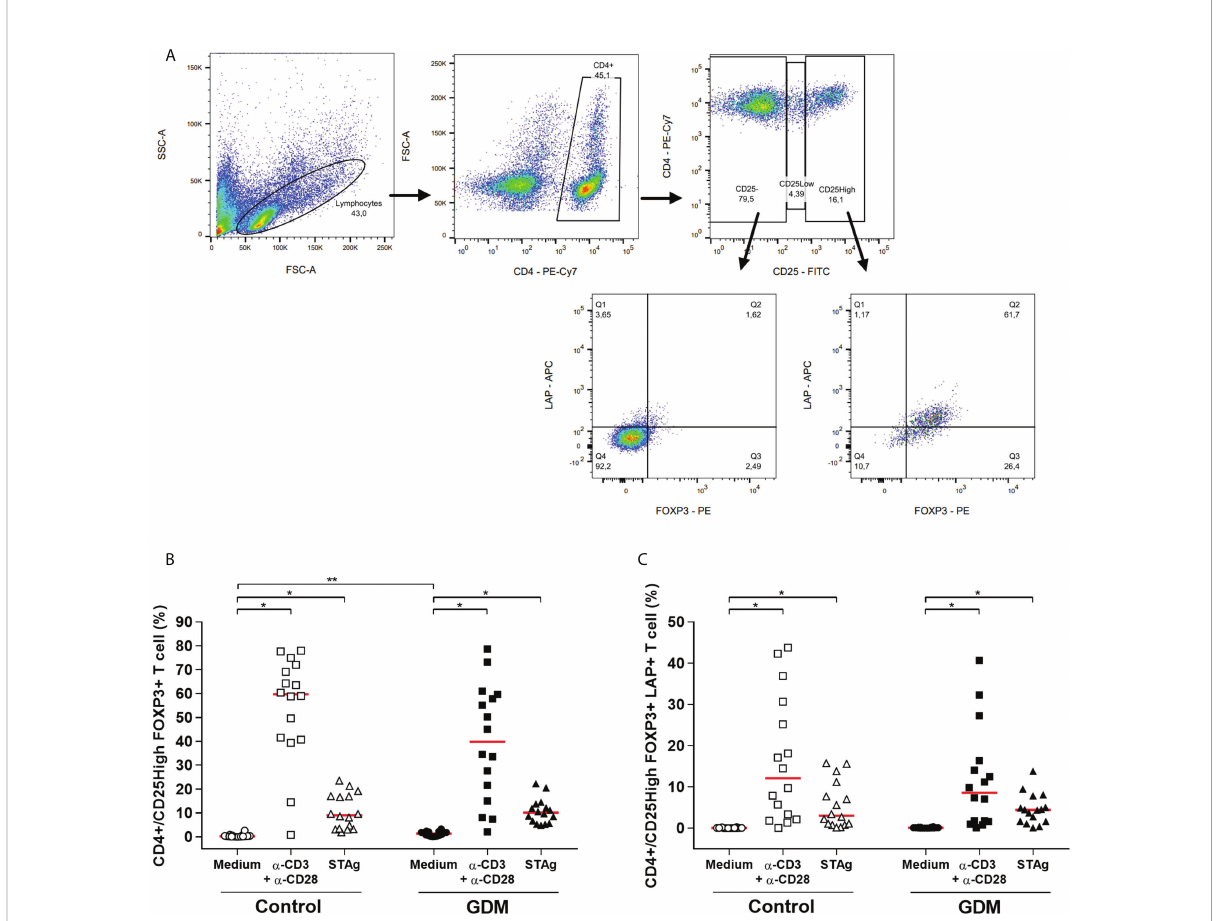
FIGURE 7 Regulatory T cell phenotype. (A) Gating strategy employed. Percentage of (B) CD4 + /CD25 High FOXP3 + , (C) CD4 + /CD25 High FOXP3 + LAP + T cells, which were acquired by fl ow cytometry of PBMC cells from 32 pregnant women (16 GDM and 16 controls) after 96 hours of culture in three different conditions (medium, polyclonal a -CD3/ a -CD28 stimulus and speci fi c STAg stimulus). The red line represents the median of the values. Statistically signi fi cant data, p < 0.05 *Wilcoxon **Mann-Whitney U test. GDM, Gestational diabetes